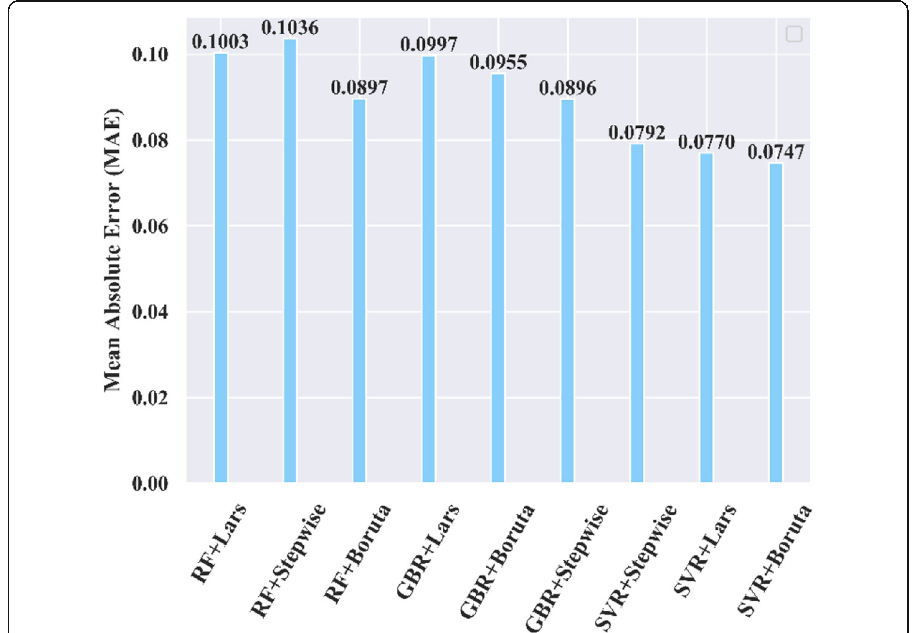
Fig. 5 The MAE comparison of nine hybrid